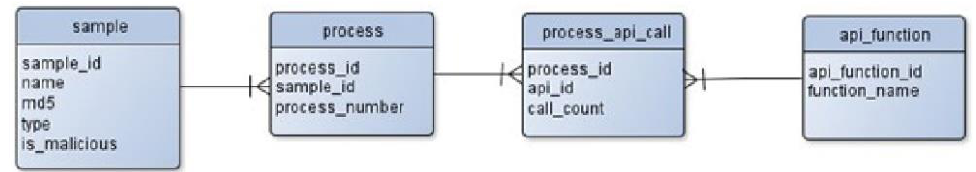
Figure 3. Entity-relationship diagram of the database used to store API call profits. Table 2. Database table record